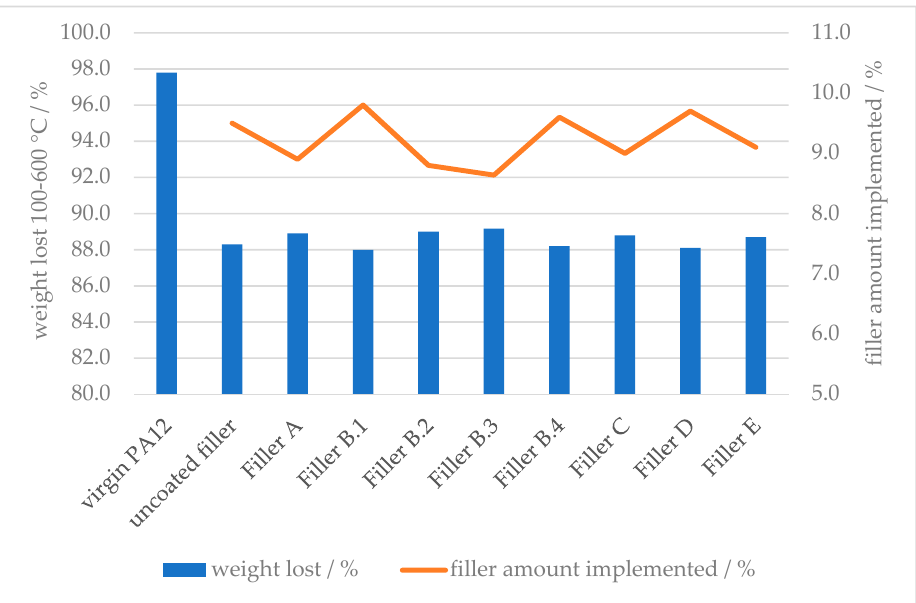
Figure 6. Thermogravimetric Analysis—weight loss and filler amount implementation.